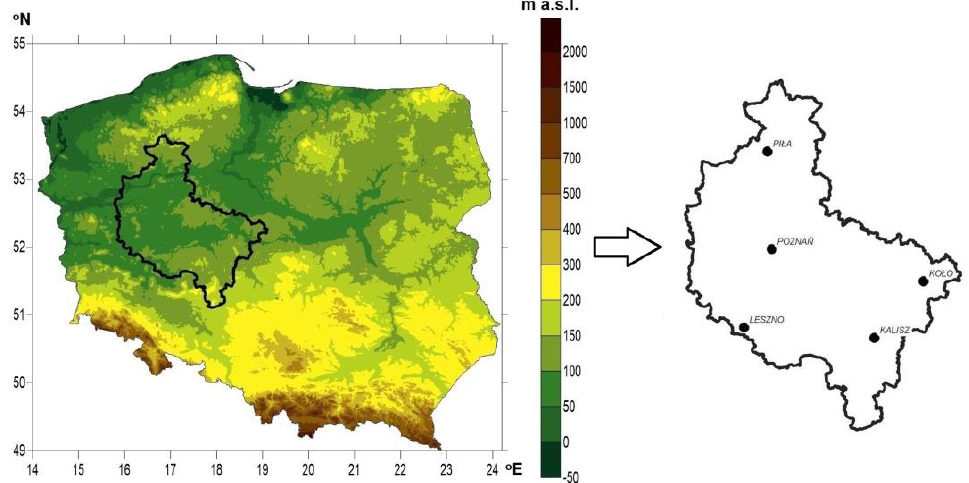
Figure 1. Poland and the location of Wielkopolskie province with the localization of synoptic stations in the province.